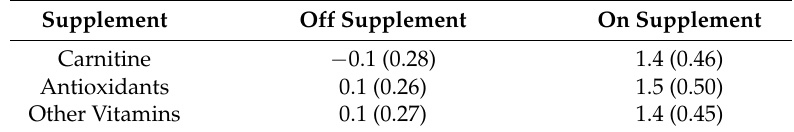
Table 2. Means (Standard Error) of Normalized Complex I activity on and off